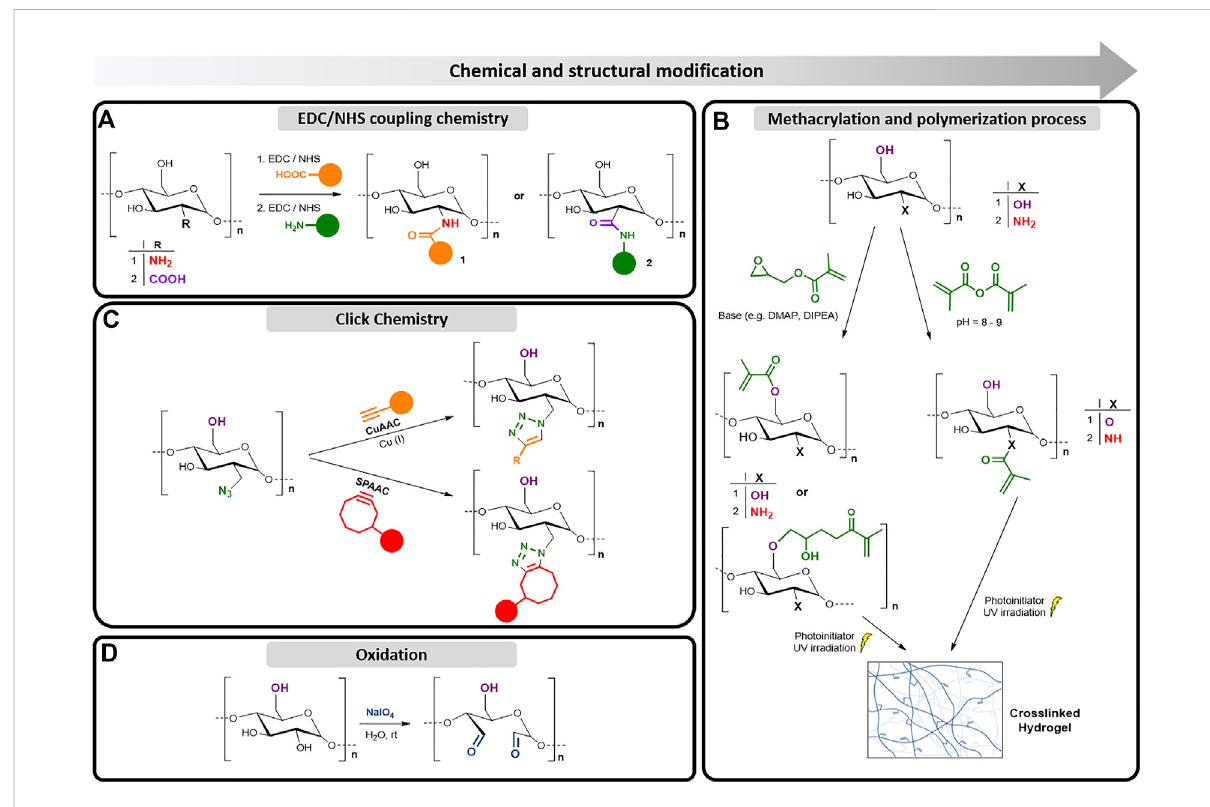
FIGURE 2 Schematic illustration of major modi fi cation strategies applied in polysaccharides based on their functional groups: (A) Conjugation to the polysaccharidesstructurewith EDC/NHScoupling chemistry; (B) Insertion ofmethacrylated moieties into thepolysaccharide backbone and photo- crosslinking reaction to produce hydrogels; (C) Click-chemistry and (D) Oxidative